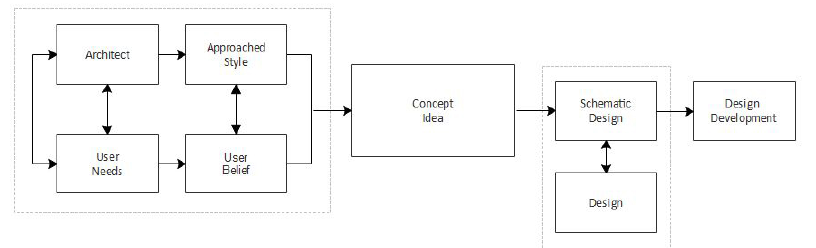
Figure 4. Interpretative participation model (source: